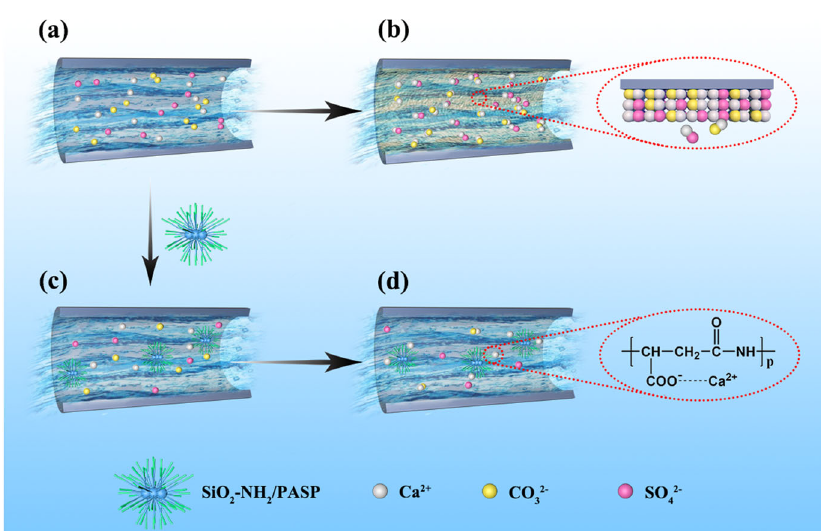
Fig. 10 Schematic illustration of inhibition mechanism of SiO 2 – NH 2 /PASP against CaSO 4 and CaCO 3 scales. a The inside of the pipe without heating and adding SiO 2 – NH 2 /PASP, b the inside of the pipe after heating, c the inside of the pipe after adding SiO 2 – NH 2 /PASP, d the inside of the pipe after heating and adding SiO 2 – NH 2